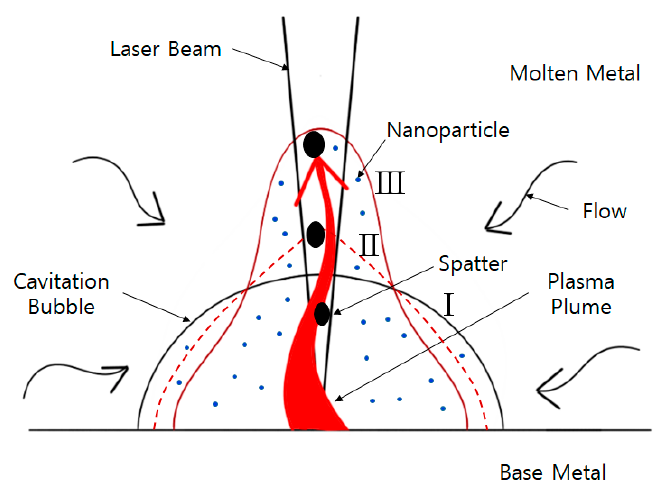
Figure 2. Modified Ibrahimkutty’s conceptual diagram for fluid flow in the cavitation bubble, immediately before the generation of evaporation products, bubble stages: hemispherical cavitation bubble (I) expansion of a cone shape bubble (II, dotted line) ejection of a spin top shape bubble (III) [50].